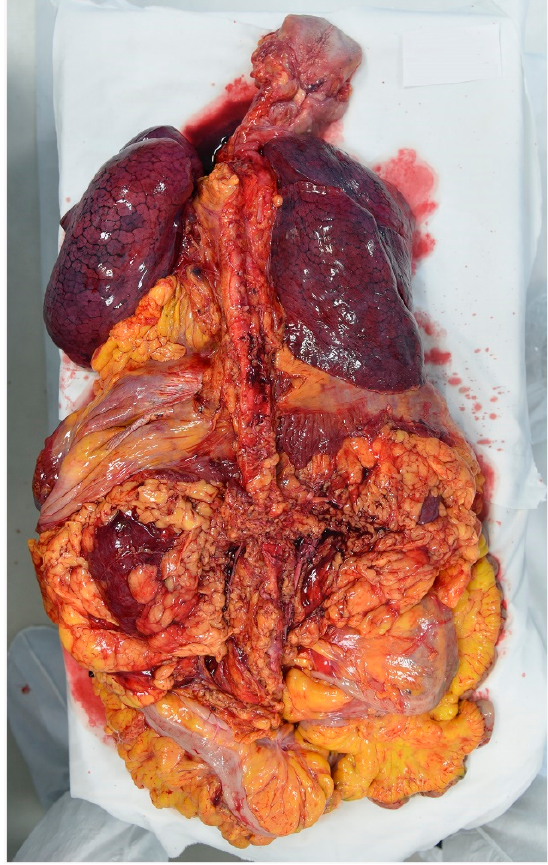
Figure 2. Anterior face of lung on the viscera obtained through the Letulle technique. Before the fixation procedures, 2 swabs were taken from the lower respiratory tract (primary bronchi): the first to the right bronchus, the second to the left bronchus. Before the cleaning and disinfection operation, 11 environmental samples were also collected at this time (T1). As indicated in Figure 1, the sampling has been performed as described: AT (4 swabs in total): (1) 40 cm from the head on a surface of 6 cm 2 (Figure 3a); (2) 40 cm from the right arm on an area of 6 cm 2 (Figure 3b); (3) 40 cm from the left arm on an area of 6 cm 2 ; and (4) 40 cm from the feet on an area of 6 cm 2 .